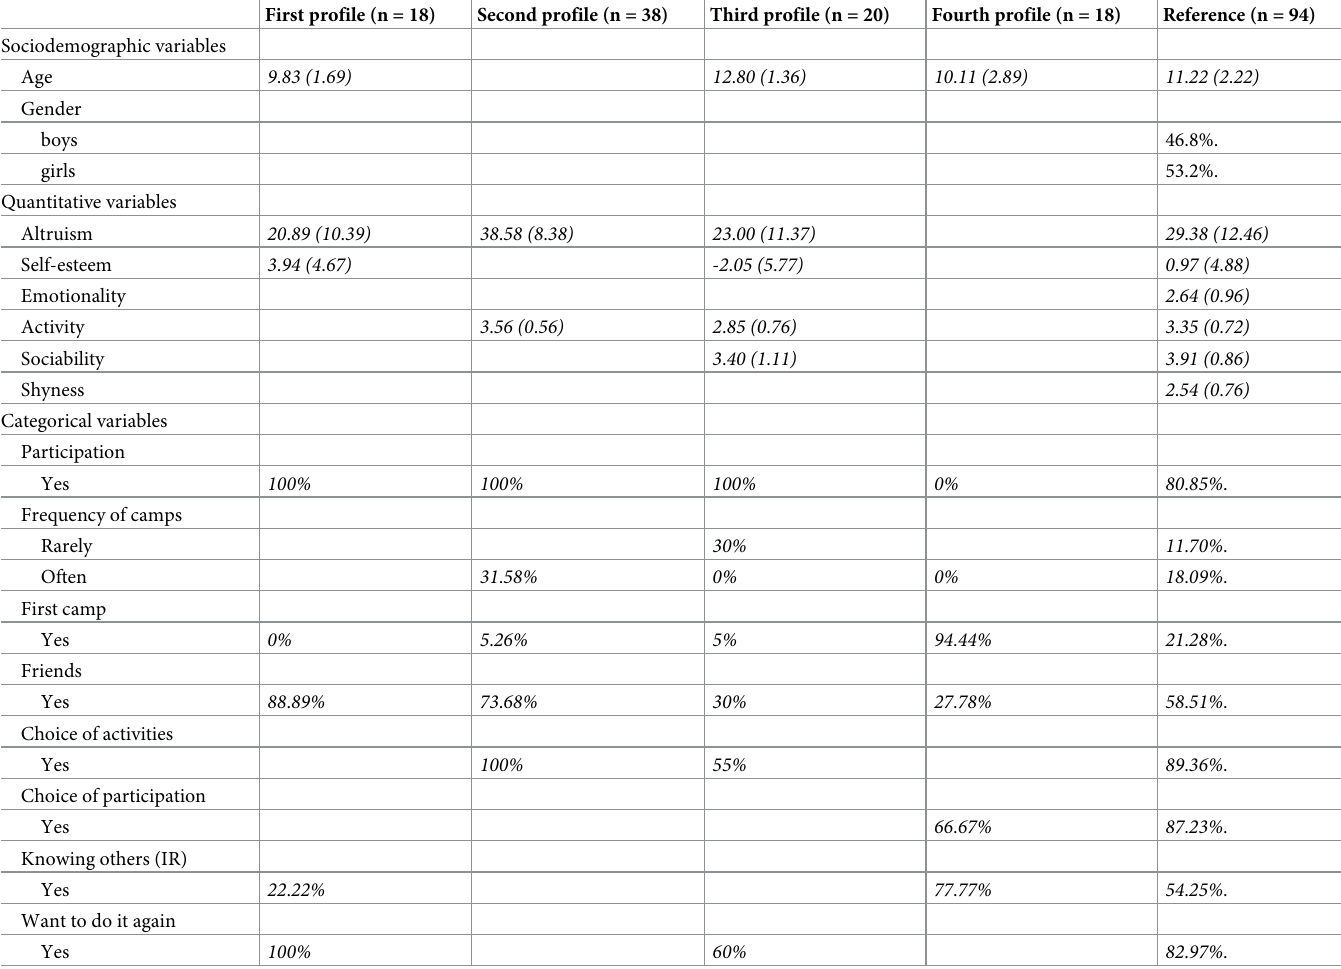
Table 3. Summary of the four profiles identified by the hierarchical